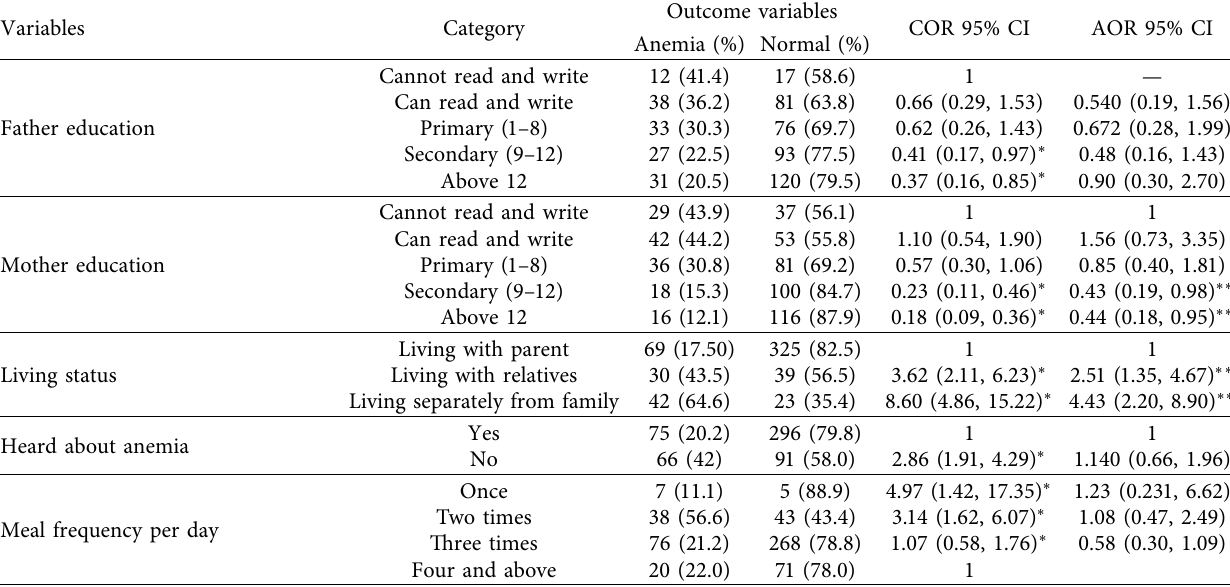
Table 3: Binary and multivariable logistic regression model to identify factors associated with anemia among adolescent high school girls in Jimma town, Oromia, southwest